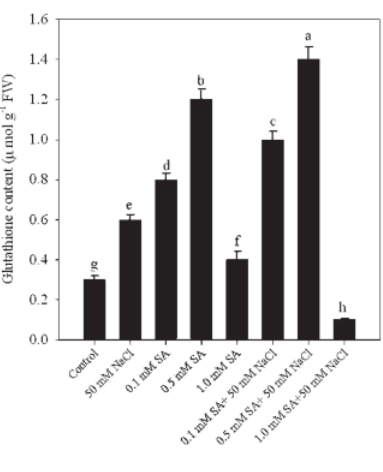
Figure 5. Effect of salicylic acid spray at 15 days after sowing (DAS) on the content of glutathione (GSH) in the leaves of mung- bean ( Vigna radiata L.) plants grown with 0 or 50 mM NaCl at 30 DAS. Values are mean±SE. Data labeled by the same letter did not differ significantly at